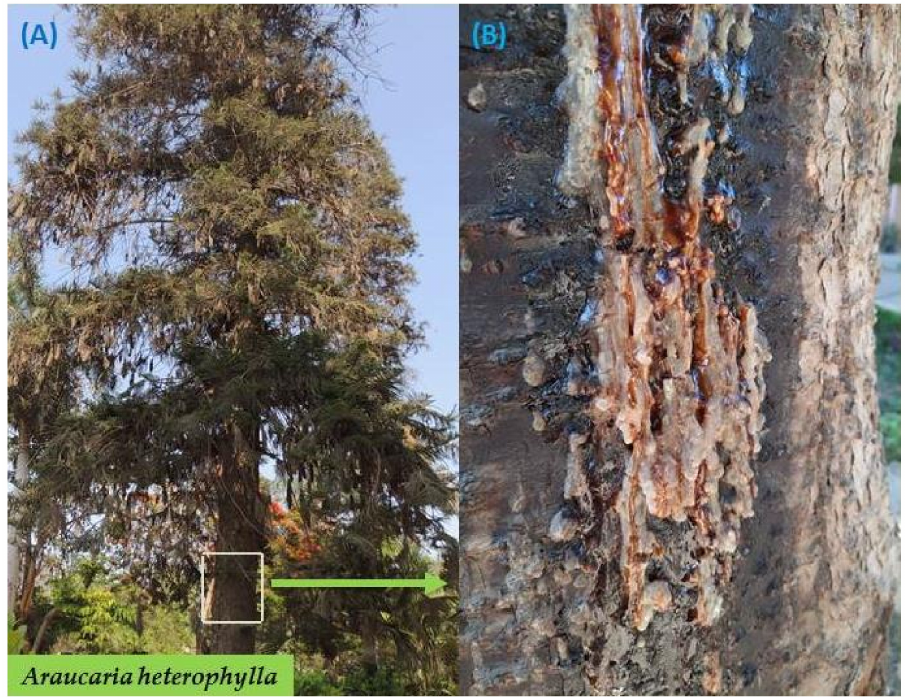
Figure 1. The tree of Araucaria heterophylla in Saint Catherine area ( A ), massive resinous sap outpour- ing of the trunk Araucaria heterophylla ( B